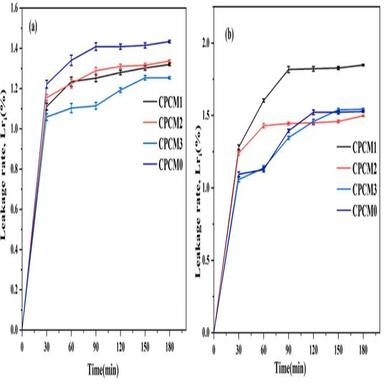
Leakage rates of CPCMs at different temperature: (a) 40 ◦C (b) 50 ◦C.